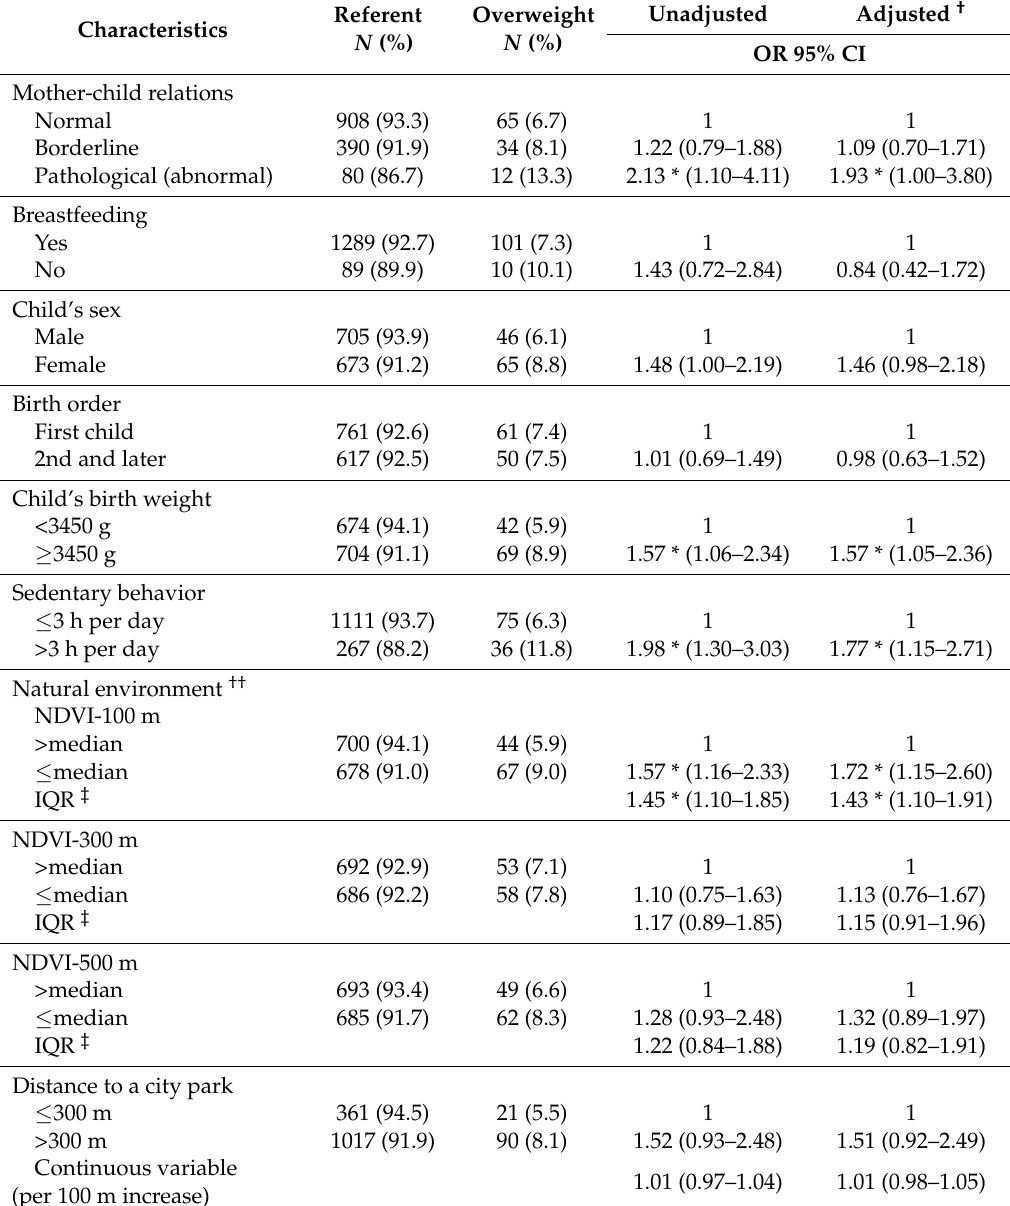
Table 3 provides unadjusted and adjusted associations between the greenness exposure and children being overweight/obese. With reference to the group of high greenness exposure (NDVI-100 m > median and the distance to a city park ≤ 300 m), a greater distance to a park tended to increase the risk of overweight/obesity among children in unadjusted (by 26%) and multivariate-adjusted (by 28%) models. The prevalence of being overweight/obese was higher among children residing in areas with low greenness exposure (NDVI-100 m ≤ median and the distance to a city park >300 m), and was associated with a statistically significantly increased risk of being overweight/obese in 4–6 year-old children. The OR was 2.27 (95% CI 1.12–4.62) after adjustment for family status, maternal